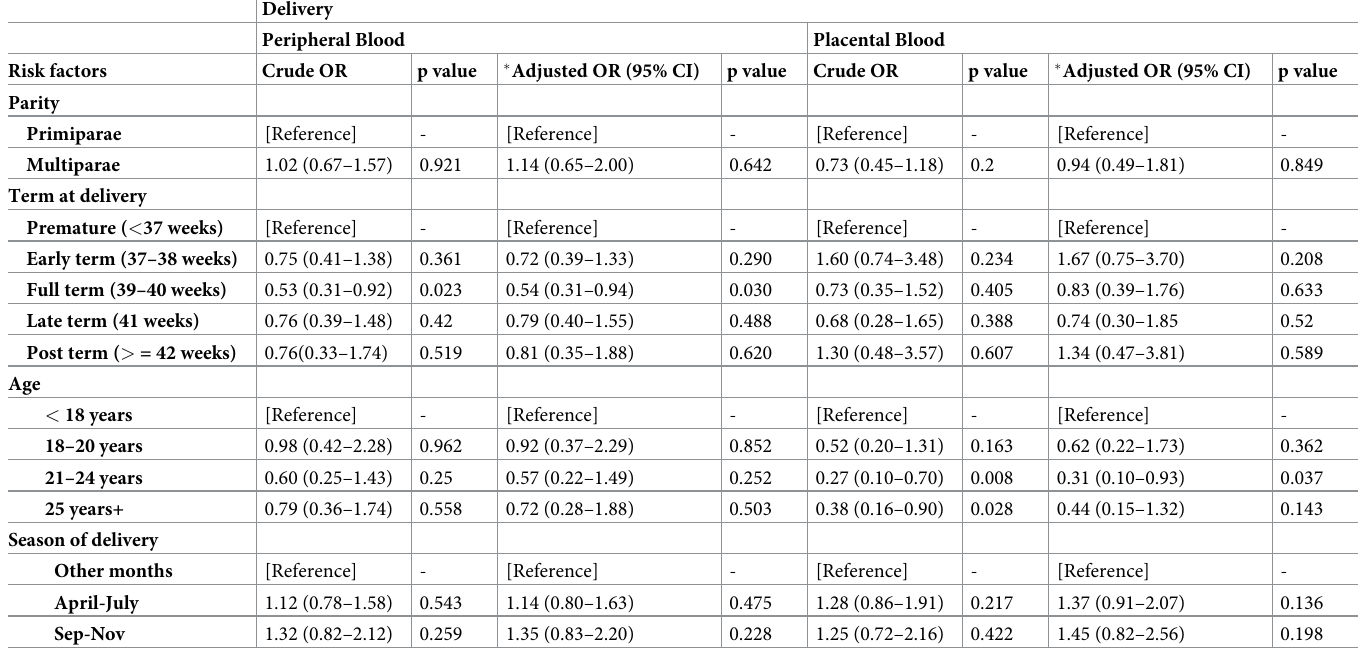
Table 6. Risk factors for P . falciparum malaria infections at delivery.